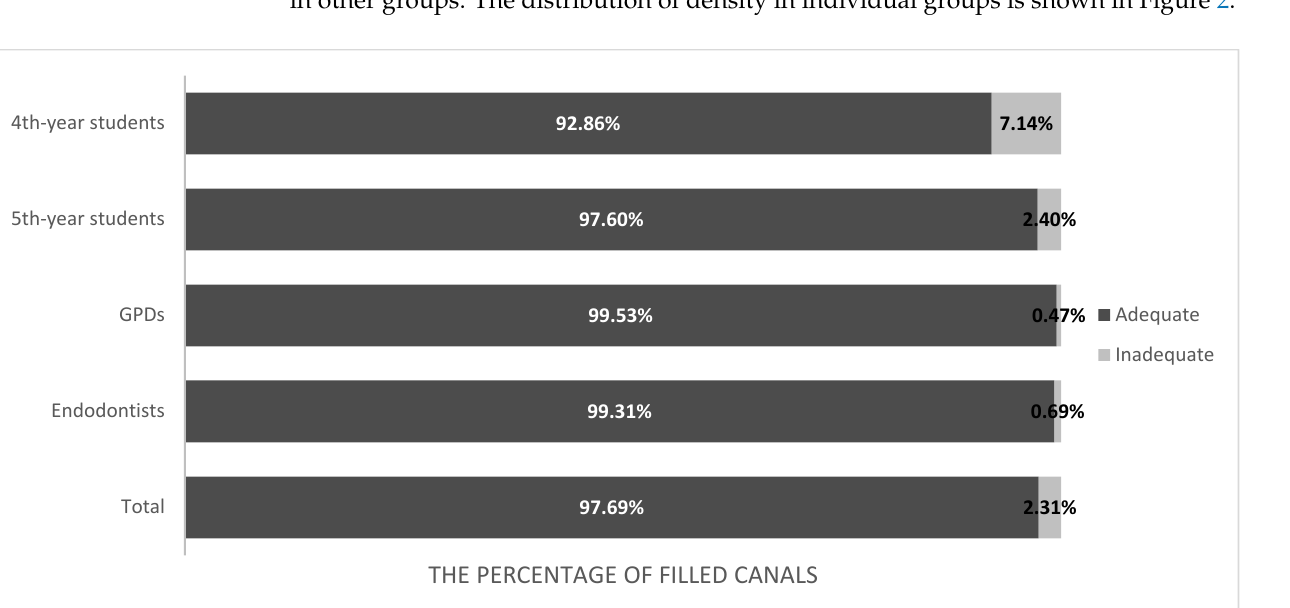
Table 2. The distribution of root canal filling length in each group. Group/Diagnoses Adequate